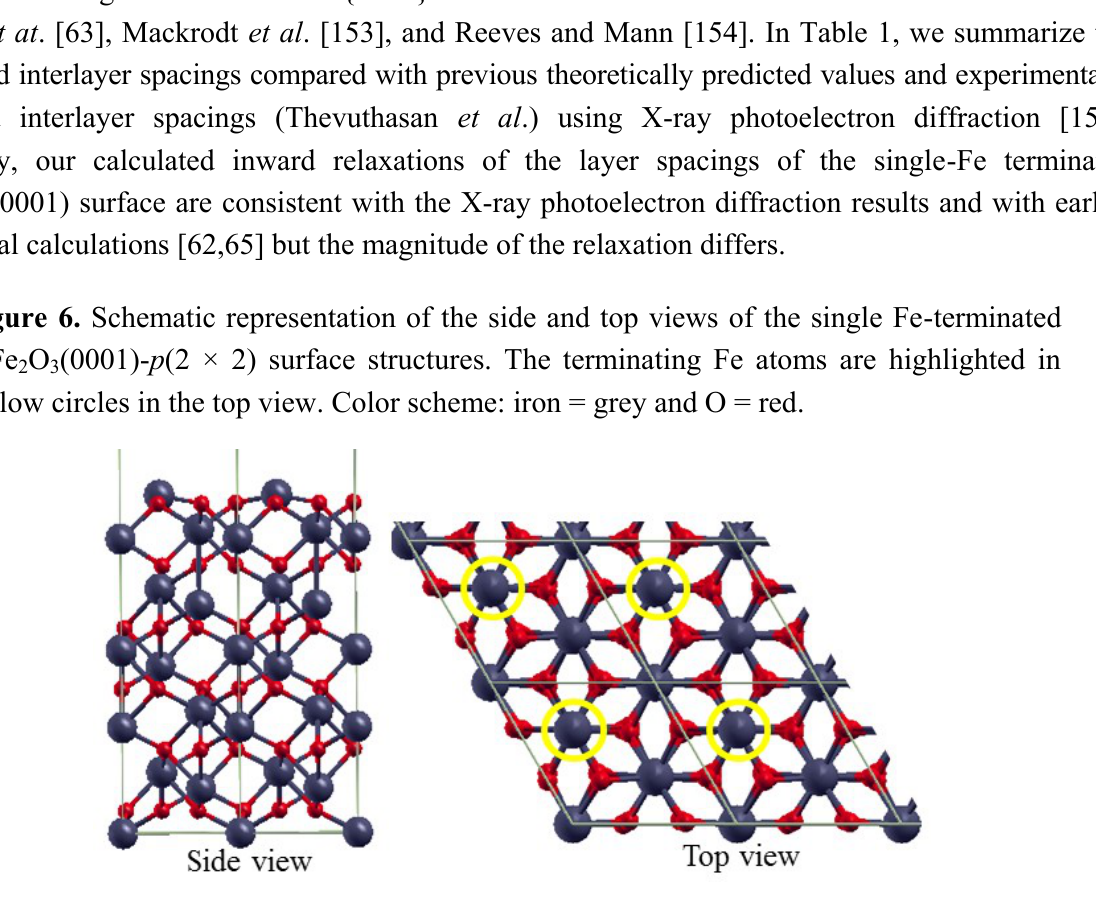
Table 1. Optimized interlayer spacing (Å) and percent relaxations for the single-iron terminated α-Fe O (0001) 2 3